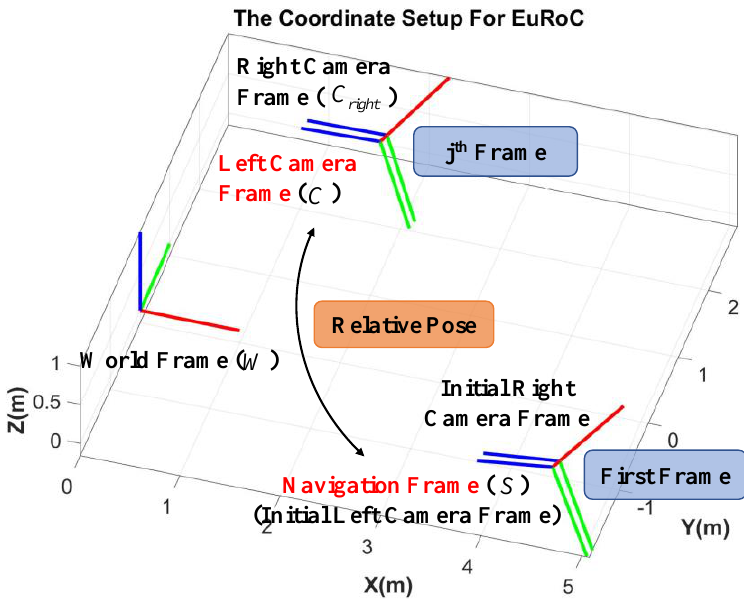
Figure 2. Illustration of navigation frame.